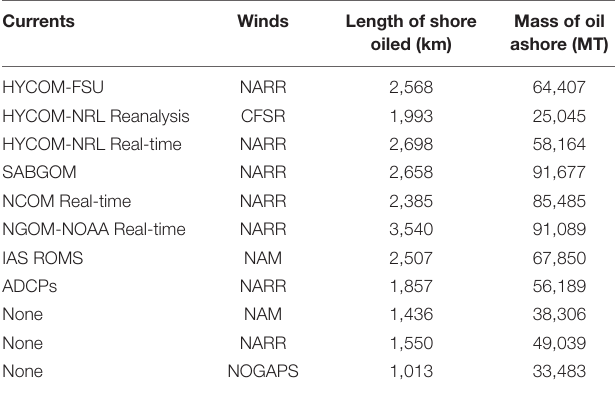
TABLE 2 | Shoreline oiling results for model cases, varying currents and winds used as